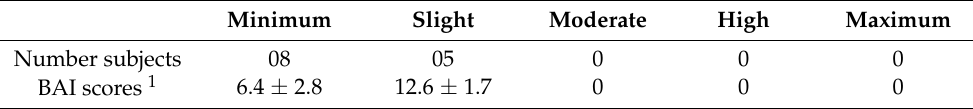
Table 2. BAI scores of novice jiu-jitsu athletes before an official competition (N = 13).